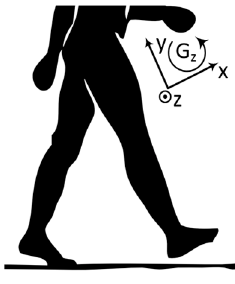
Figure 5. Reference axis of IMU data.